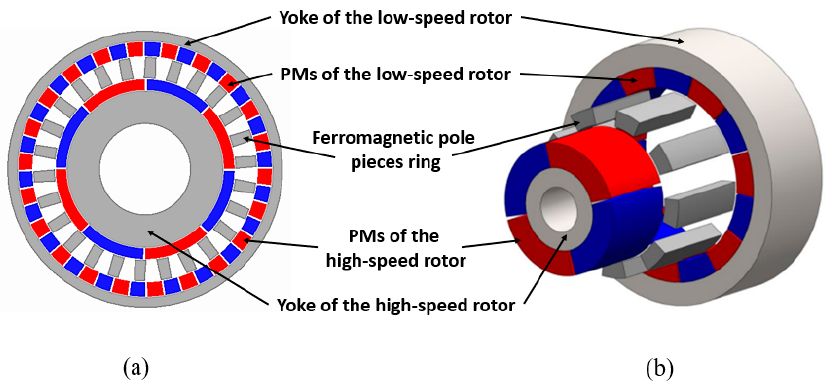
Figure 7. Field modulating magnetic gear. Main elements of its active components: ( a ) Front view; ( b ) Isometric view.